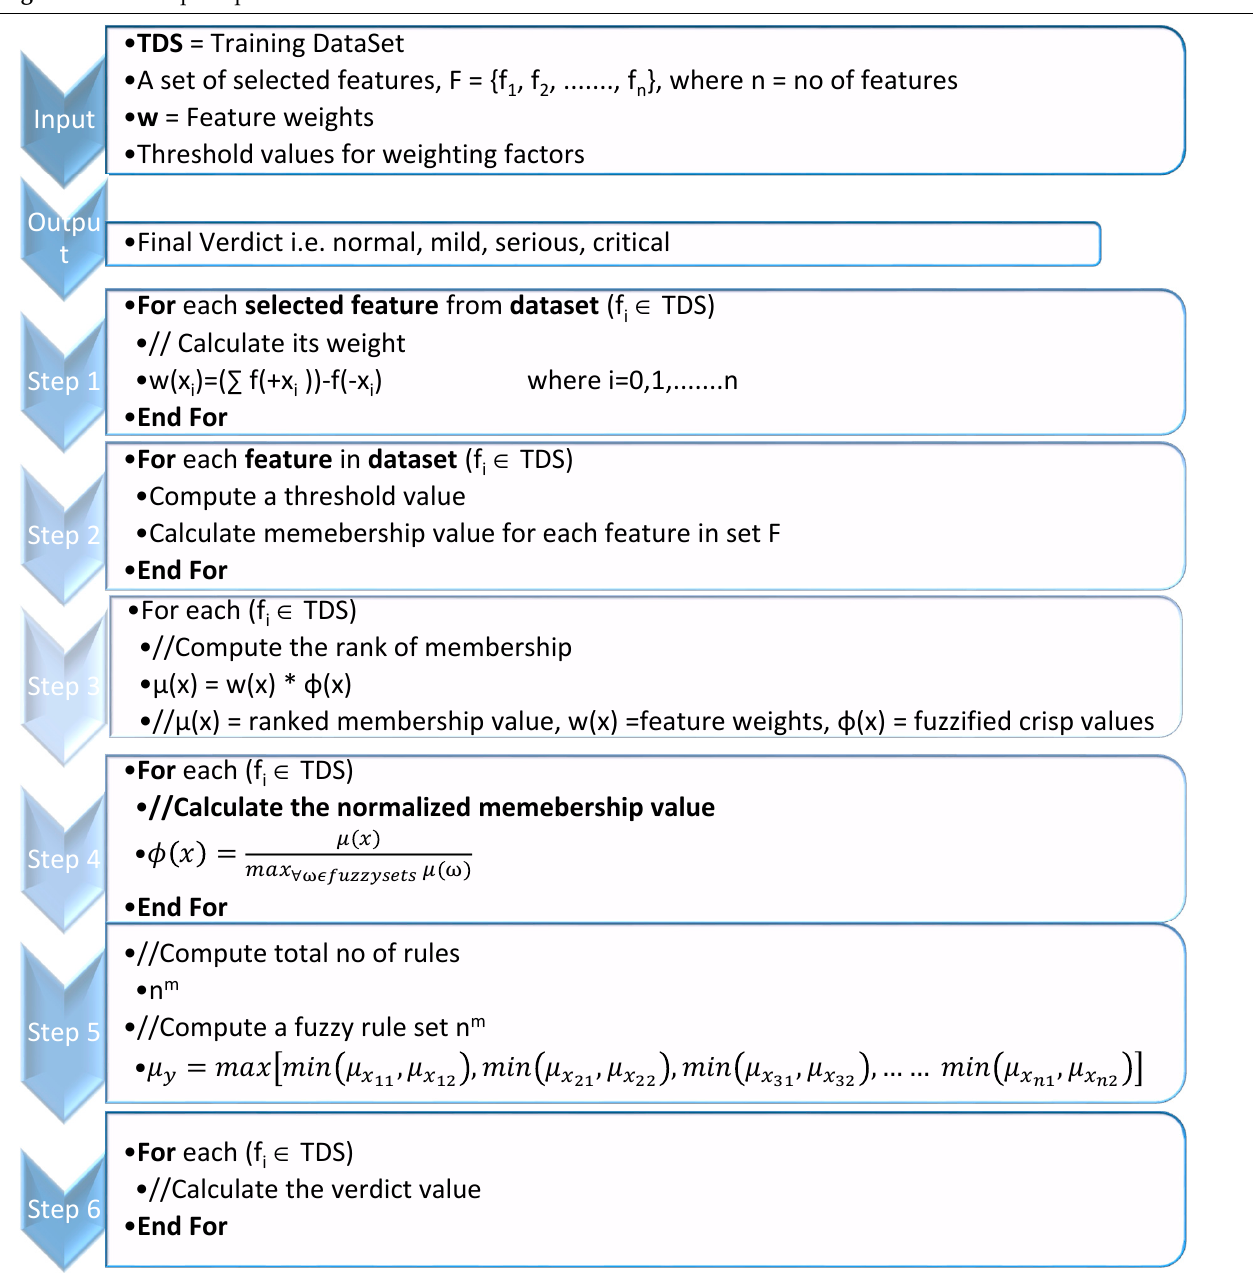
Algorithm 4. Complete process of FLCD.